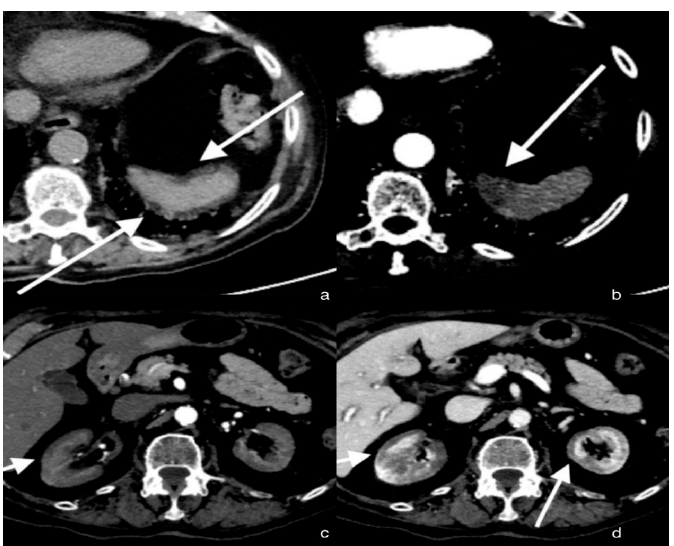
Figure 1. Axial sections of the abdomen in the basal ( a ) and arterial ( b ) phases; the arrows show a small hypo-dense subcapsular area well delimited by the splenic capsule. This area in the arterial phase remains as a hypodense lesion. Lack of enhancement. Axial section of the abdomen in the arterial ( c ) and portal venous ( d ) phases; the arrows show a non-enhancing renal cortex. Images show a normal enhancing renal medulla (acute cortical necrosis), and the hypodense cortex is surrounded by a thin peripheral rim of enhancement in the portal venous